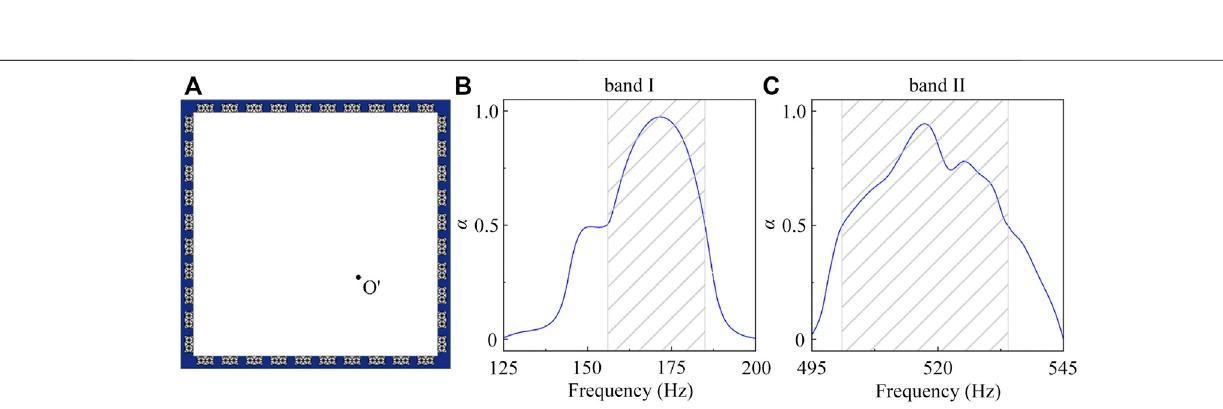
FIGURE 5 | Simulated total pressure distributions in the barrier-free anechoic room at (A) 173 Hz and (B) 519 Hz, and its corresponding re fl ected intensity distributions at (C) 173 Hz and (D) 519 Hz. White points at the center of the room are the positions of cylindrical sound source.